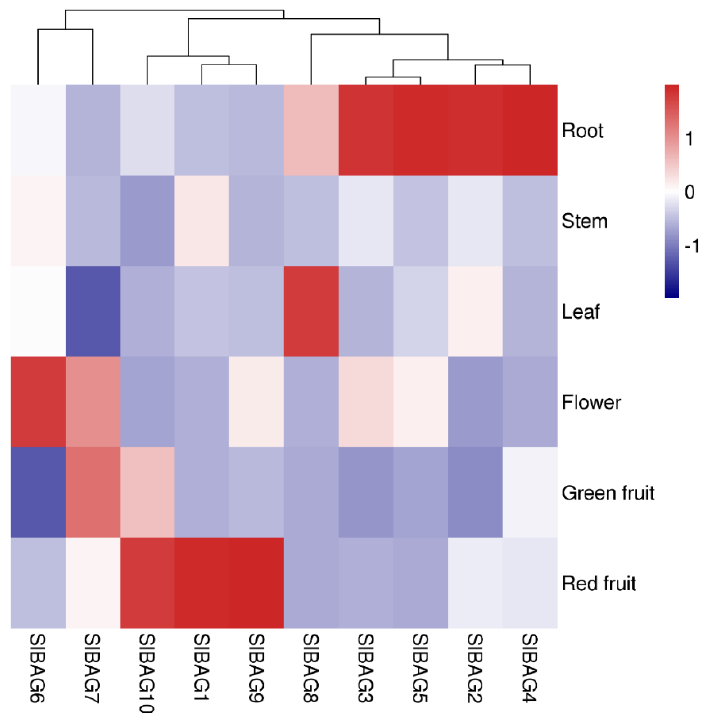
Figure 4. Expression profiles of SlBAG genes in different organs of tomato. The heatmap shows the expression change of ten SlBAG genes. Total RNA was extracted from different organs (root, stem, leaf, flower, green fruit, and red fruit) for qRT-PCR. Three independent biological repeats were performed ( n = 3). The bar in the upper right corner represents the expression value of log2, and the change of expression level is represented by the change of color. Red indicates relatively high expression and blue indicates relatively low expression.